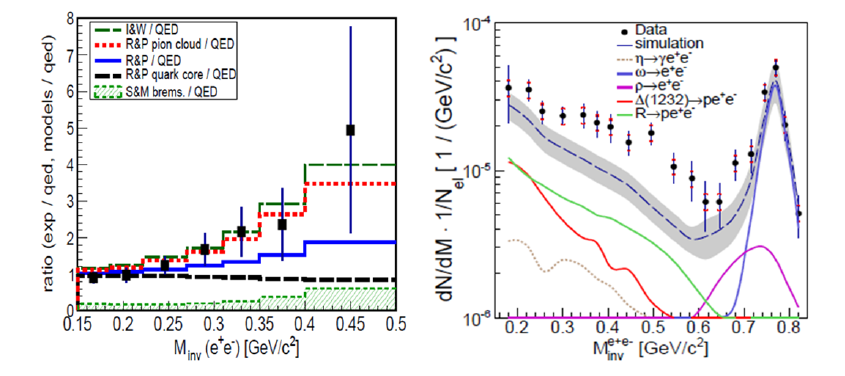
Figure 1. Left: Ratio of the e + e − invariant mass distribution in the pp → pp e + e − reaction at 1.25 GeV expected for a point-like (’QED’) transition and the predictions with form factor models [7] (I&W) (dashed dark green) and [8] (R&P) (full blue: total, dashed red: meson cloud contribution, dashed black: quark core contribution) (see [9]). Right: Dielectron invariant mass distribution in the pp → pp e + e − X reaction at an incident energy of 3.5 GeV compared to simulation results. For the baryon Dalitz decay (green curve), point-like BN γ ∗ couplings are used and the resonance production cross sections are fixed using pionic channels. For details, see